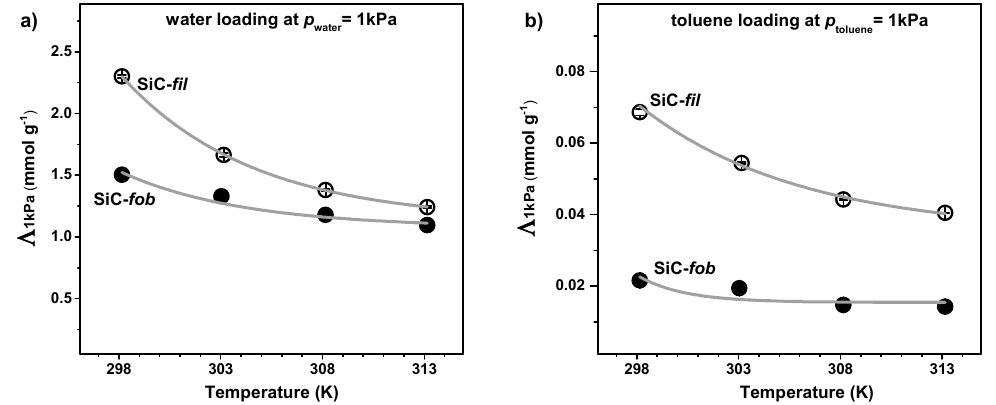
Figure 5. Uptake at 1kPa( Λ 1kPa ) of ( a ) water and ( b ) toluene for the membrane materials before and after modification (SiC- fil and SiC- fob , respectively) in the temperature range between 298 and 313 K.